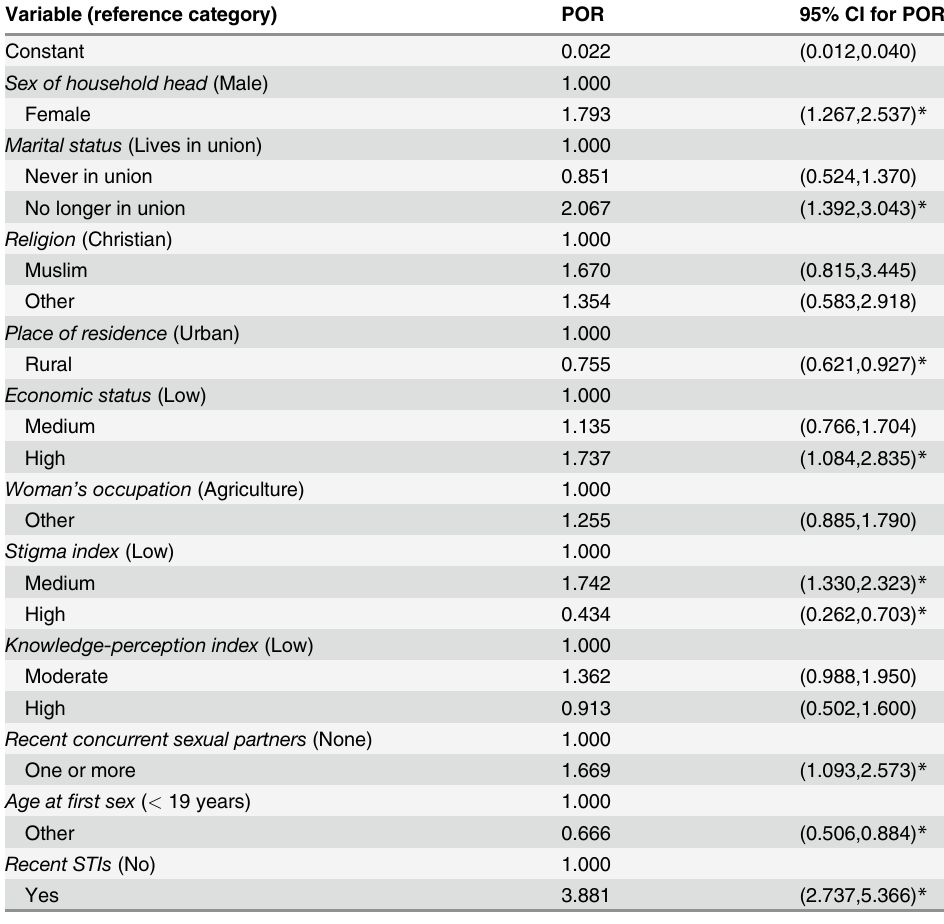
Table 4. Posterior odds ratio (POR) estimates for fi xed effects with 95% credible intervals based on Model 5. Variable (reference